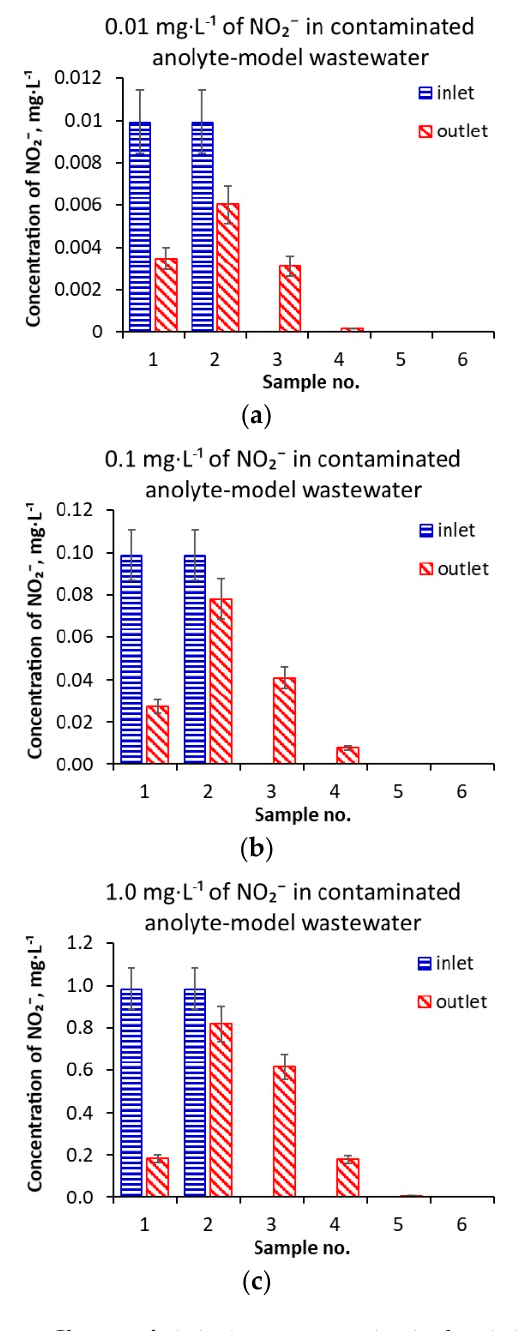
Figure 7. Change of nitrite ion concentration in the nitrite ion-contaminated anolyte-model wastewater at outlet of the microbial fuel cell (MFC) anode half-cell, when nitrite ion concentration at inlet was ( a ) 0.01 mg · L − 1 ; ( b ) 0.1 mg · L − 1 ; ( c ) 1.0 mg · L − 1 ; ( d ) 10 mg · L − 1 ; ( e ) 100 mg · L − 1 ; ( f ) 1000 mg · L − 1